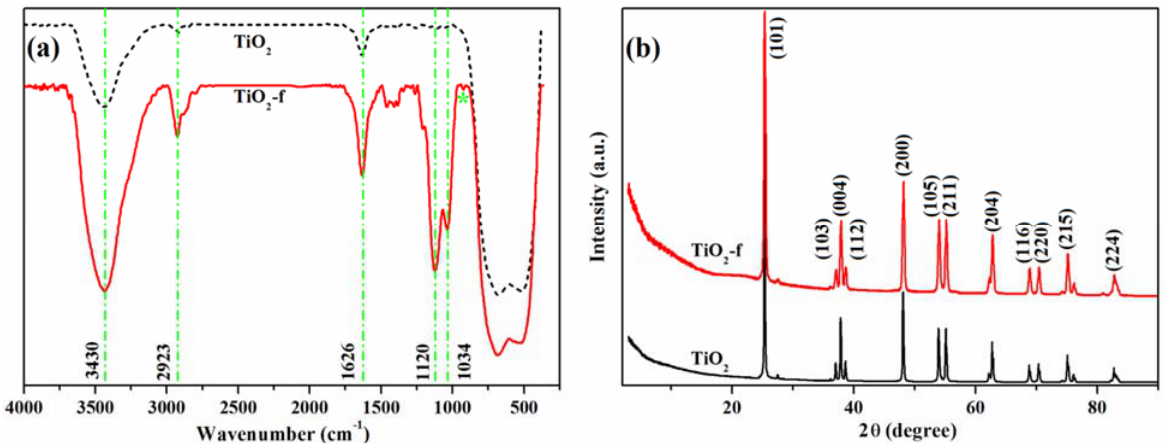
Figure 1. FTIR spectra ( a ) and XRD diffractograms ( b ) of the commercial TiO 2 and functionalized TiO 2 NPs. Therefore, besides a broad Ti–O–Ti absorption band (400–700 cm − 1 ), the OH groups’ absorption band (3430 cm − 1 ) or molecular water (3430 and 1626 cm − 1 ), the new TiO 2 functionalized nanoparticles presented the Si–O–Si asymmetric stretching vibration at 1120 and 1034 cm − 1 along with the intensification of the methylene groups’ characteristic band (2923 cm − 1 ). The absorption band due to the vibration of Ti–O–Si new bonds was identified as a small shoulder at 922 cm − 1 [38]. The X–ray diffraction patterns of the commercial and functionalized TiO 2 NPs are illustrated in Figure 1b. The analysis of the spectra indicated that the pristine TiO 2 nanoparticles are in the anatase structure (peaks identified according to the TiO 2 Anatase COD card number 9015929), information confirmed by the presence of strong diffraction peaks at 25.37° and 48.1° specific to the anatase phase [39,40]. The crystallinity of the sample is reflected by the intense XRD peaks, and the crystallite size calculated from the diffraction peaks using the Debye–Scherer formula is about 45 nm. As expected, after modification with IPTMS, TiO 2 -f nanoparticles showed a similar pattern as the starting TiO 2 , since no phase transformation or changes in the crystalline structure took place during the functionalization. 3.2. Synthesis and Characterization of Polyurethane/TiO 2 Composites To obtain new hybrid materials based on polyurethane matrices and functionalized TiO 2 nanoparticles, the quaternization of tertiary amino units from polyurethanes with iodide-modified TiO 2 NPs was performed (Figure 2), aiming at achieving a covalent bonding between the organic and inorganic components, which subsequently could lead to polymer composites with improved properties. In the preparation of the materials, the functionalized nanoparticles were mixed in 1/1 and 1/0.5 molar ratios with polyurethane solutions in THF, which allowed the obtaining of four composites, namely PU-1-0.5, PU-1-1.0, PU-2-0.5 and PU-2-1.0 (initial molar compositions are given in Table 1).